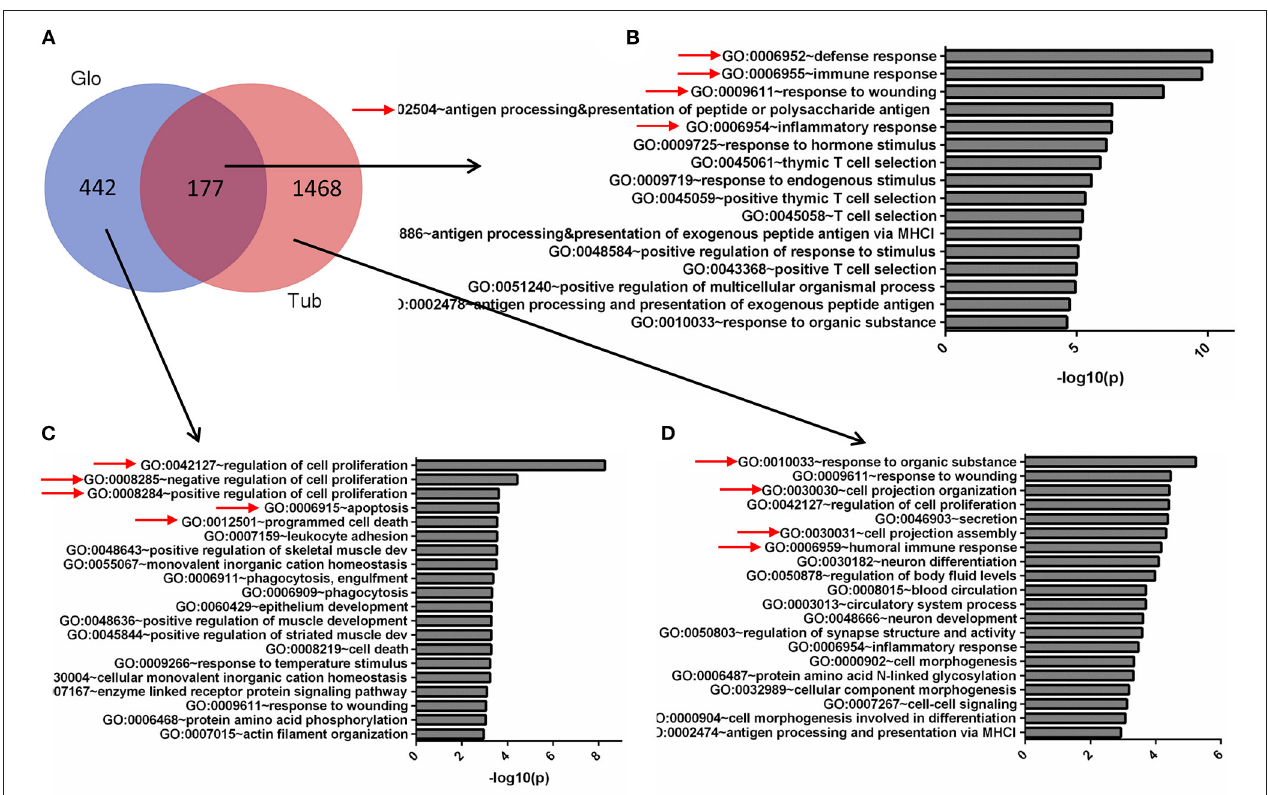
FIGURE 2 | Gene Ontology (GO) terms of glomerular and tubular DEGs. (A) Venn diagram for the overlapping comparison of glomerular and tubular DEGs. GO terms of (B) glomerular and tubular overlapping DEGs, (C) tubular unique DEGs, and (D) glomerular unique DEGs. Significance is expressed as a p -value calculated using Fisher’s exact test ( p < 0.05) and shown as –log 10 ( p